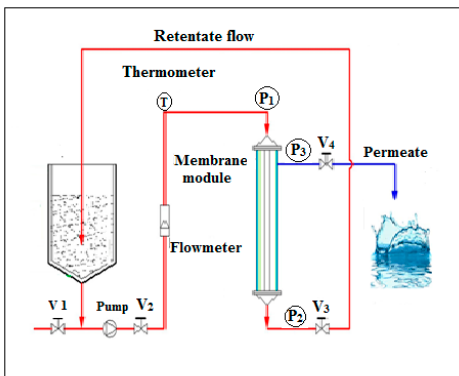
Figure 1. Schematic representation of crossflow Ultrafiltration experiment set-up.